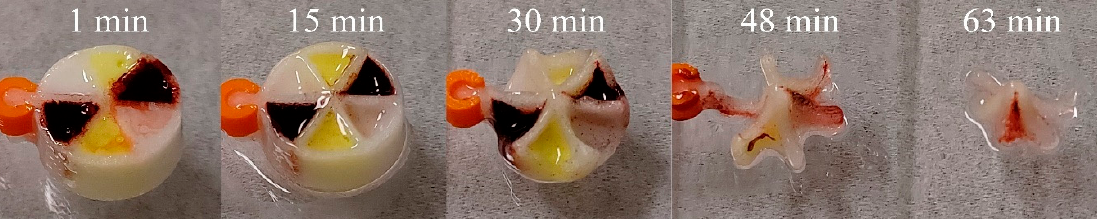
Figure 13. Photo series demonstrating the erosion of PVOH multicompartment tablets when retrieved form the dispersion medium at different time points (see Figure S3 for full photoset).